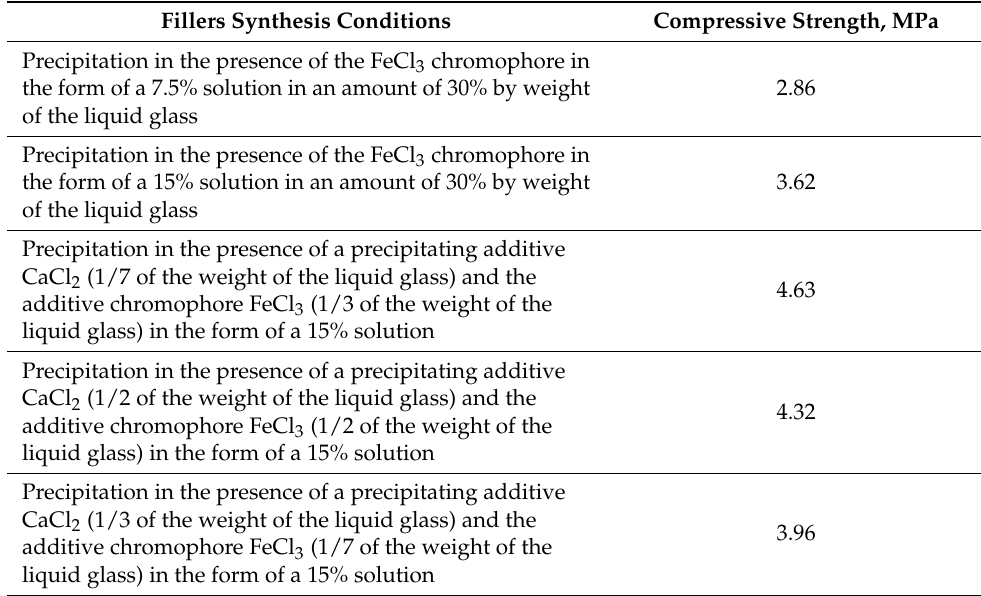
Table 5. Compressive strength of the lime composites (specimens 005A).